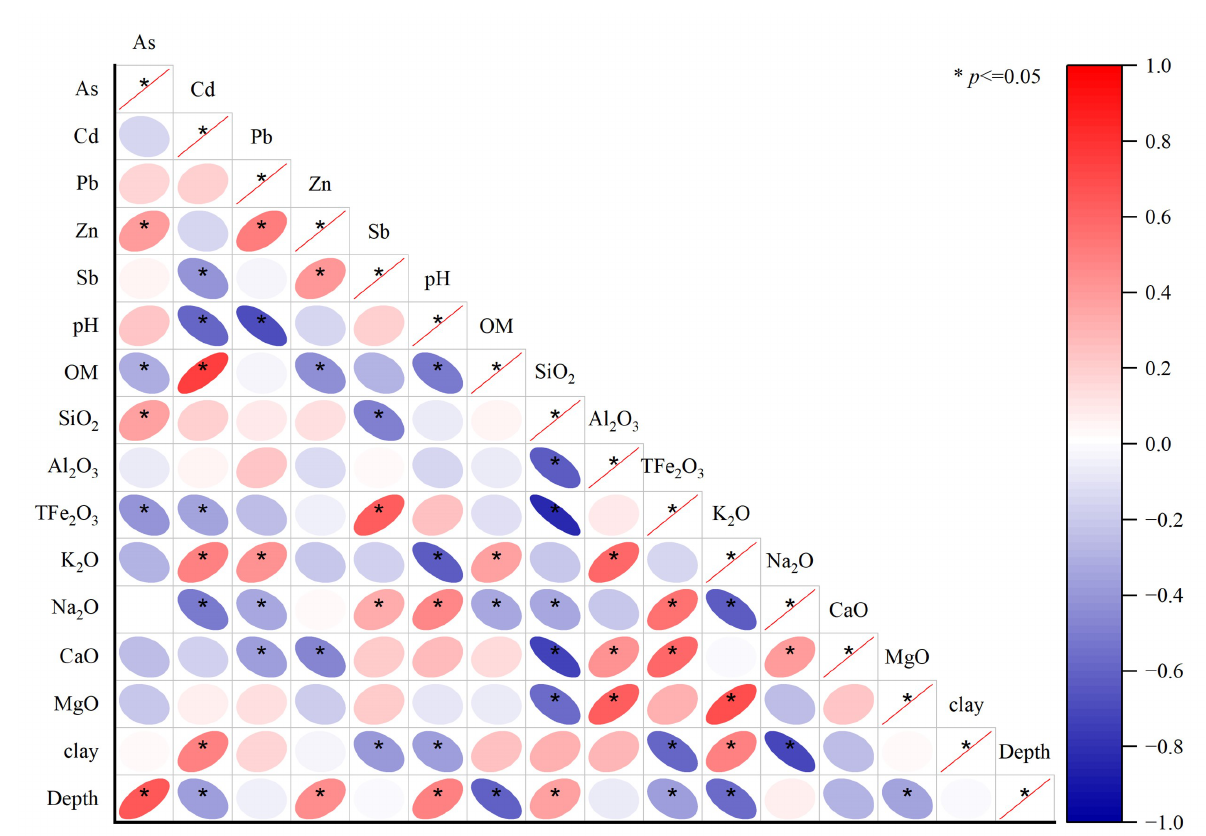
Figure 7. Correlation between bioavailable metals and physicochemical properties in profile soil samples in the study